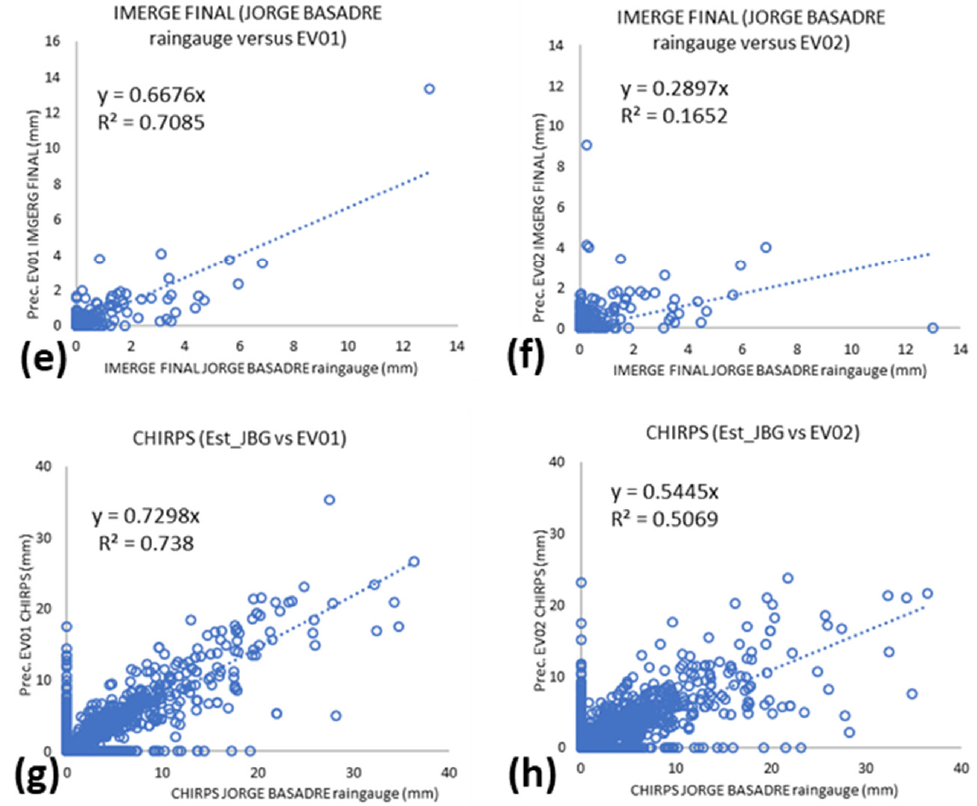
Figure 9. Correlations were made between the total daily precipitation data between the JORGE BASADRE rain gauge and the virtual rain gauges, (EV01 and EV02) using the products: ( a , b ) PISCO, ( c , d ) IMERGE Early, ( e , f ) IMERGE Final, and ( g , h ) CHIRPS.